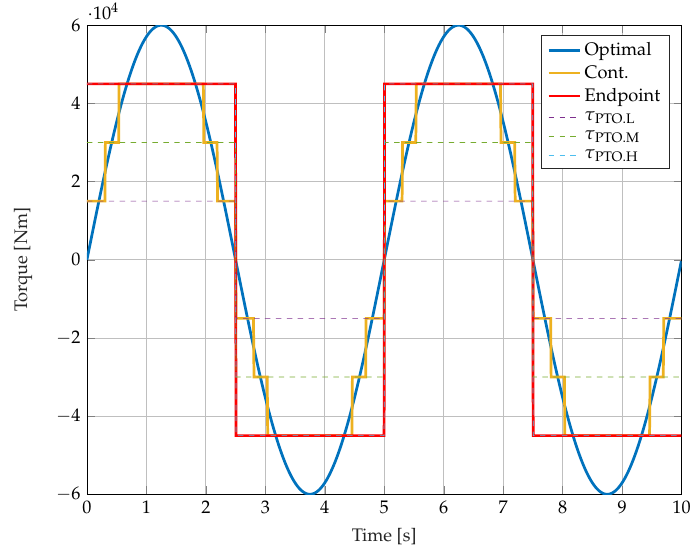
Figure 8. Torque levels for different resistive WPEAs compared to the optimal.